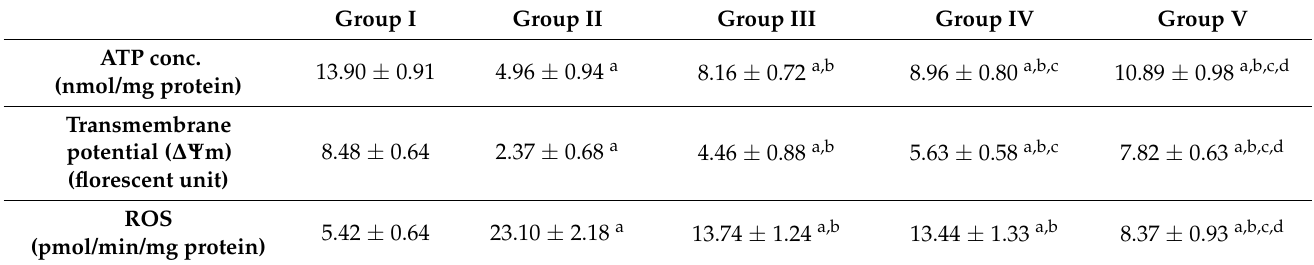
Table 1. Mitochondrial